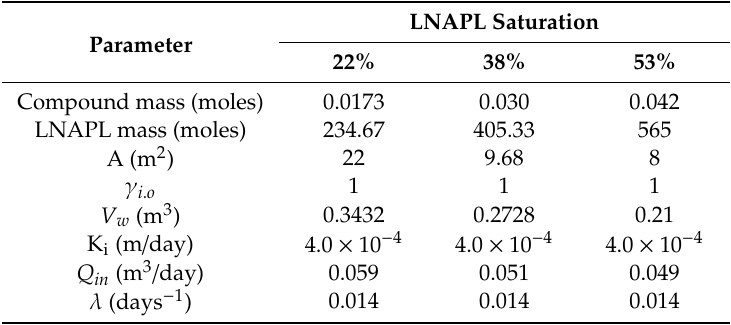
Table 3. Model parameters for three distinct simulated scenarios. The model parameterization was based on the variation of the LNAPL saturation in the pore space, i.e., 0.23, 0.38, and 0.53.